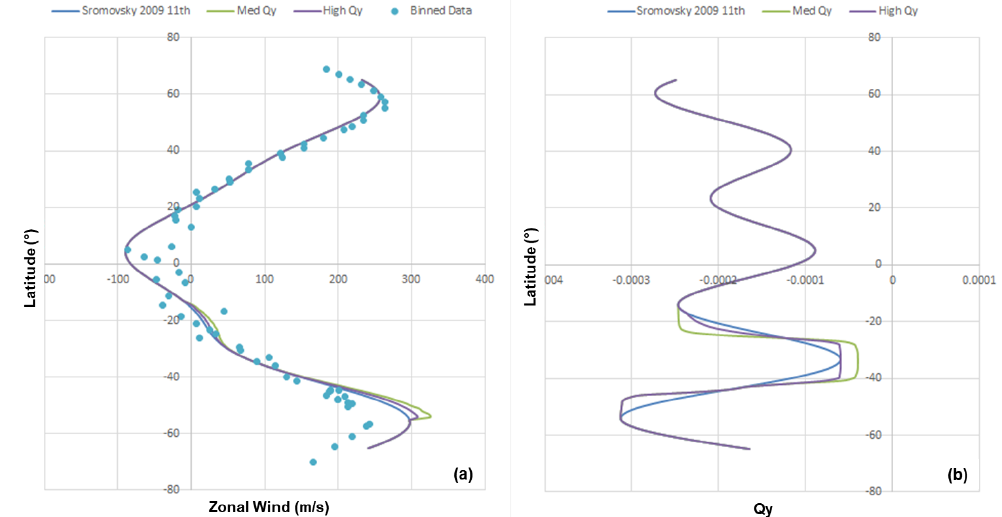
Figure 2. Uranian zonal wind profiles used in this study, with : ( a ) Zonal wind profiles including 11th-order Legendre polynomial from [10] and observed cloud-tracking data binned at 1 ◦ intervals from [12]. ( b ) Derivative of the absolute vorticity with latitude, Q y , for the three profiles.